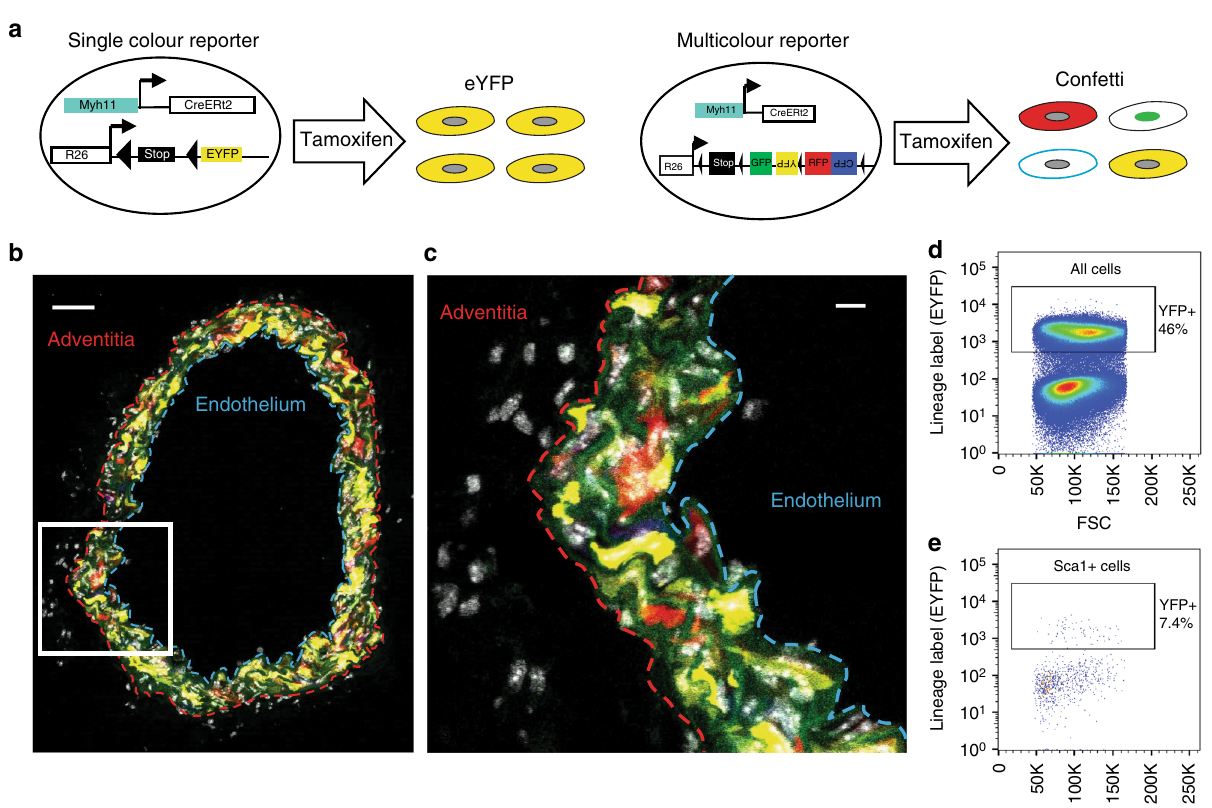
Fig. 6 VSMC-lineage cells express Sca1. a Schematic showing strategies for lineage labelling of VSMCs using a Myh11-driven, tamoxifen-inducible Cre- recombinase (CreERt2). Tamoxifen treatment activates Cre recombinase activity, resulting in VSMC-speci fi c excision of the stop codon in fl uorescent reporter transgenes inserted into the Rosa26 locus (R26). Left panel, the single-colour EYFP reporter. Right panel, the multicolour Confetti reporter, which results in stochastic labelling of VSMC-lineage cells with one of four fl uorescent proteins (GFP, YFP, RFP, CFP). b , c Maximum projection of a 12 µ m transverse cryosection from the carotid artery of an Myh11-CreERt2/Confetti animal one week after tamoxifen labelling. Confetti fl uorescent proteins are shown in red (RFP), yellow (YFP), blue (CFP) and green (nuclear GFP), elastic lamina auto fl uorescence in green and nuclear DAPI in white. The white boxed region in b is magni fi ed in c , and the dashed lines show the medial-adventitial (red) and medial-endothelial (blue) borders in each panel. Scale bars are 50 µ m ( b ) and 10 µ m ( c ). d , e FACS plot showing forward scatter (FSC) and EYFP expression in all ( d ) or gated Sca1 + cells ( e ) isolated from the medial layer of aortas from Myh11-CreERt2/Rosa26-EYF P